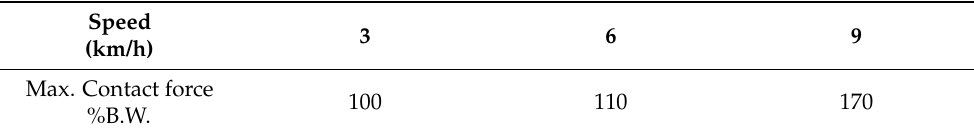
Table 3. Maximum contact force in percent of body weight (%B.W) for different gait speeds as reported in